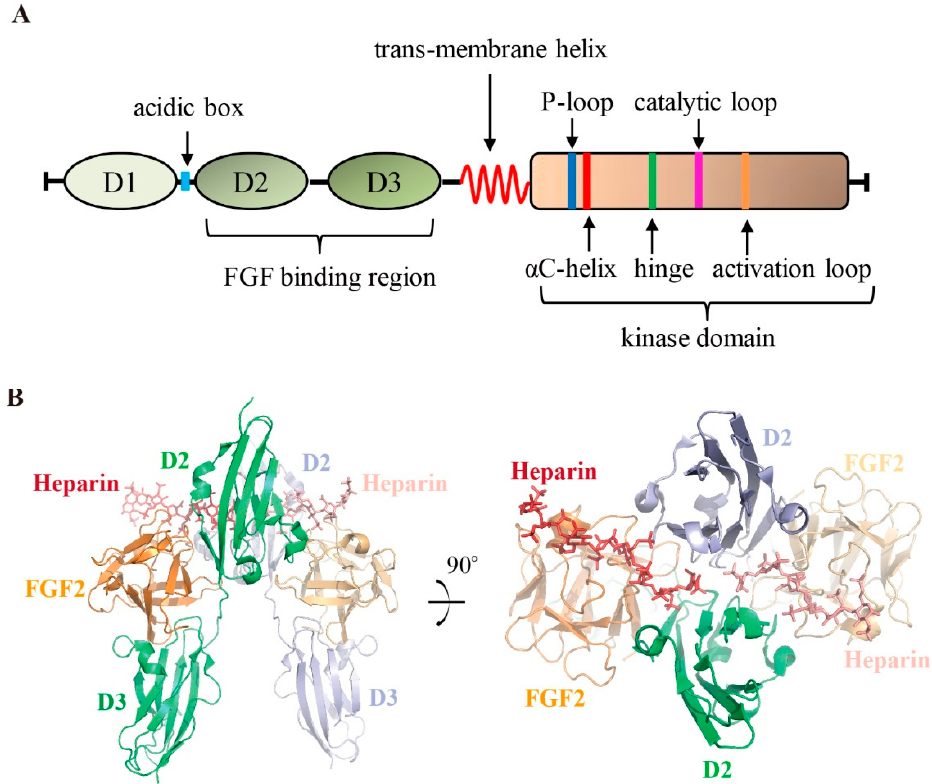
Schematic diagram of FGFRs and the structure of the FGFR extracellular domain. ( A ) Organization of FGFRs. Important functional elements are highlighted. ( B ) Crystal structure of the FGF2:FGFR1:heparin ternary complex (PDB ID 1FQ9). The two copies of FGFR1 molecules are colored in green and light blue respectively. Heparin molecules are shown in red stick representation; FGF2 (colored in orange) and FGFR1 are shown in cartoon representation.